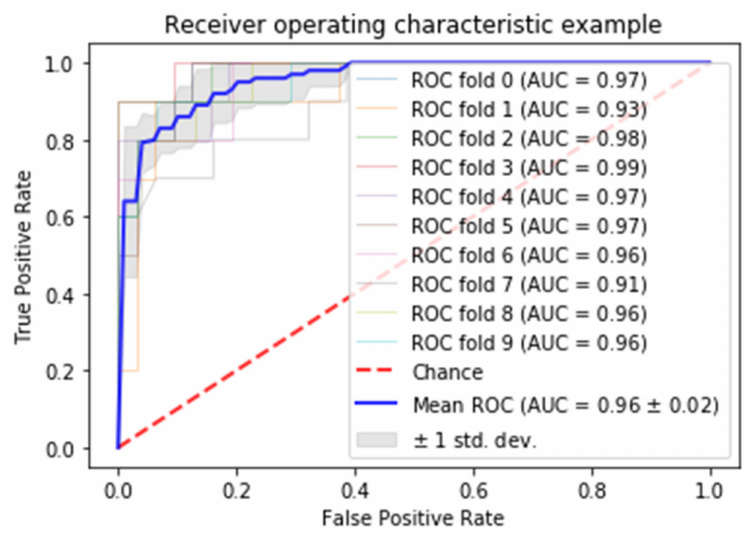
Figure 8. Receiver operating characteristic (ROC) curve. AUC—area under the